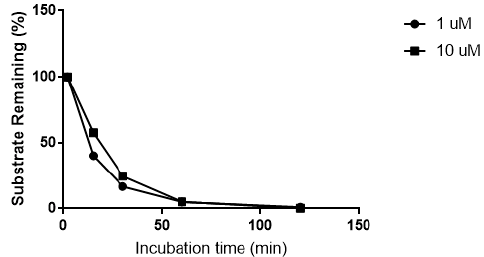
Figure 1. Biotransformation of CRV431 (1 and 10 µ M) in human liver microsomes.